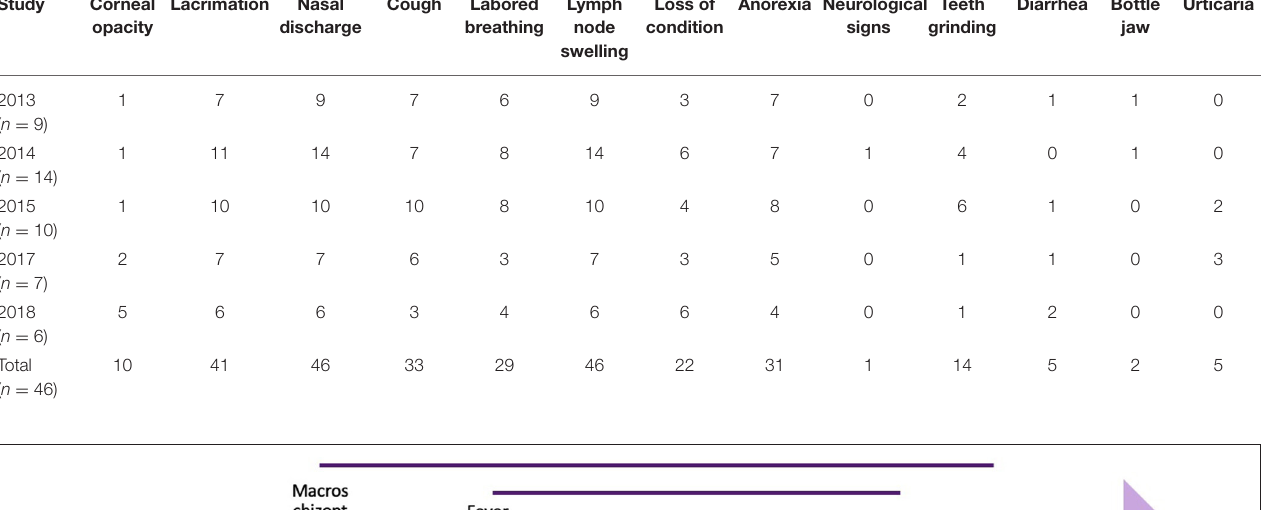
TABLE 3 | Non-continuous clinical signs observed in study animals over five trials N = 9 (2013), 14 (2014), 10 (2015), 7 (2017), and 6 (2018). Study Corneal Lacrimation Nasal Cough Urticaria opacity discharge